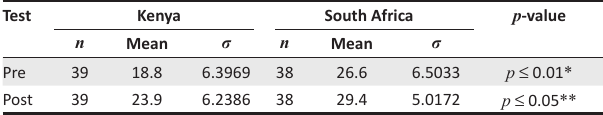
TABLE 3: Comparison of the Kenyan and South African groups mean scores in the Visual Perception Aspects Test pre- and post-tests with t test probability value ( p